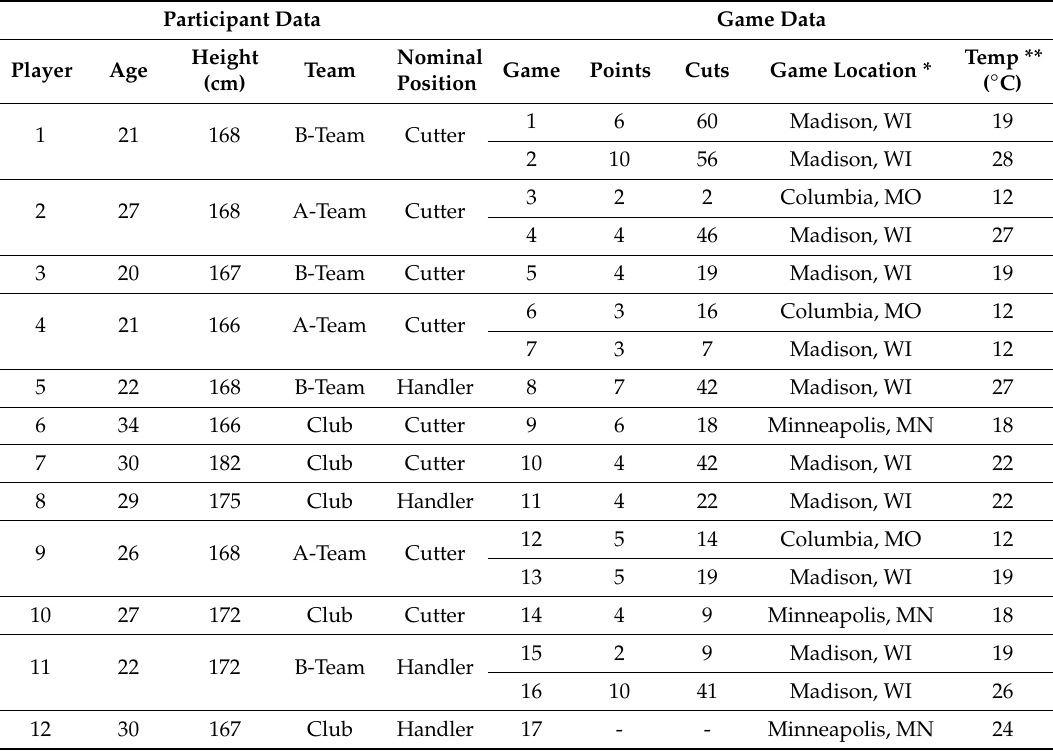
Table A1. Characteristics for Data Collected on Games and